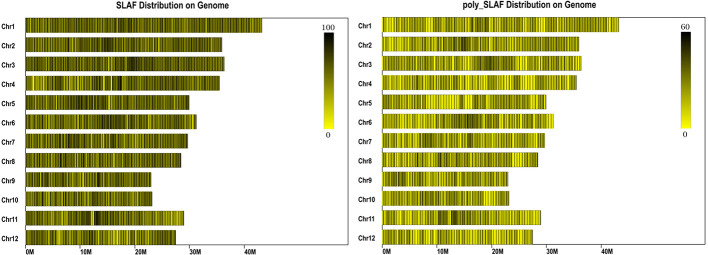
Distribution of specific length amplified fragments (SLAFs) on rice genome. The x-axes indicates chromosome length. Each yellow band represents a chromosome, each black line indicates a SLAF marker.